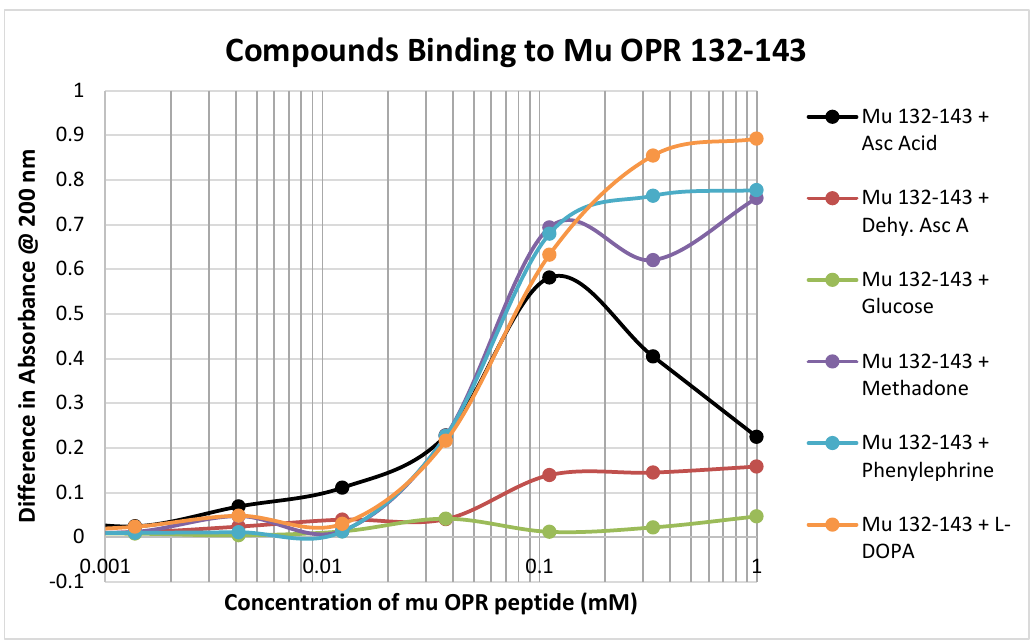
Figure 6. Binding of various compounds to muOPR 132–143. Compare with Figure 5. Additional data in Table 1.